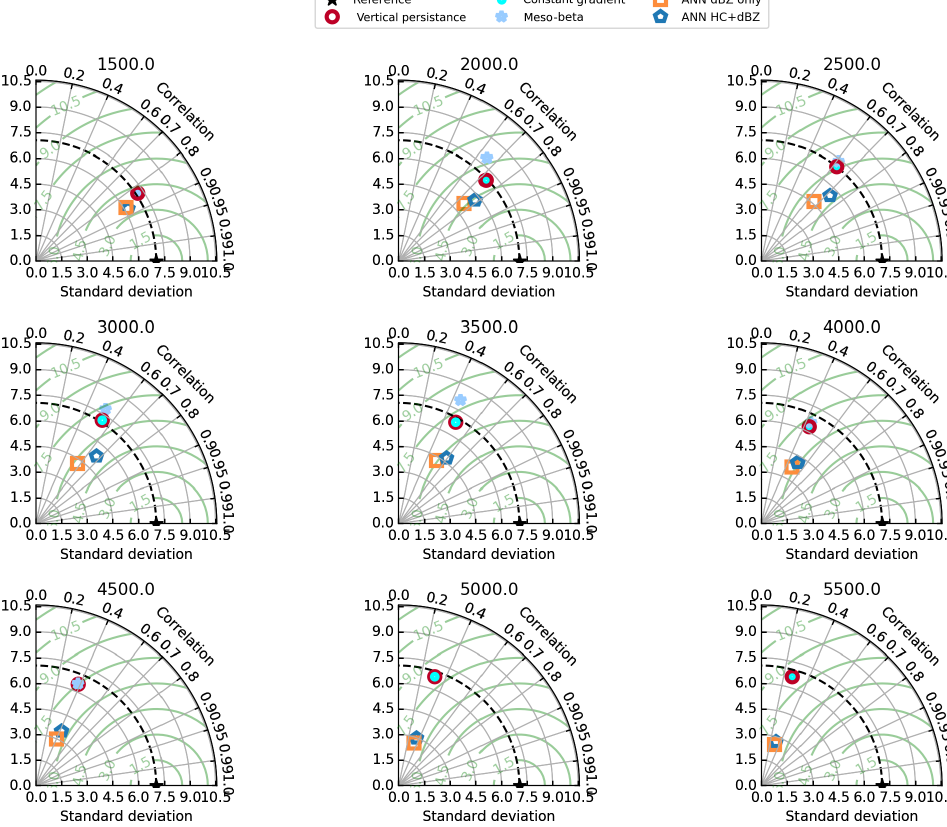
Figure 13. Taylor diagrams of models trained from increasing altitudes. Each diagram shows the relative performance of the models making predictions from increasing altitude levels and in terms of the centred RMSE (green contours), correlation coefficient (azimuth angle) and standard deviation (radial